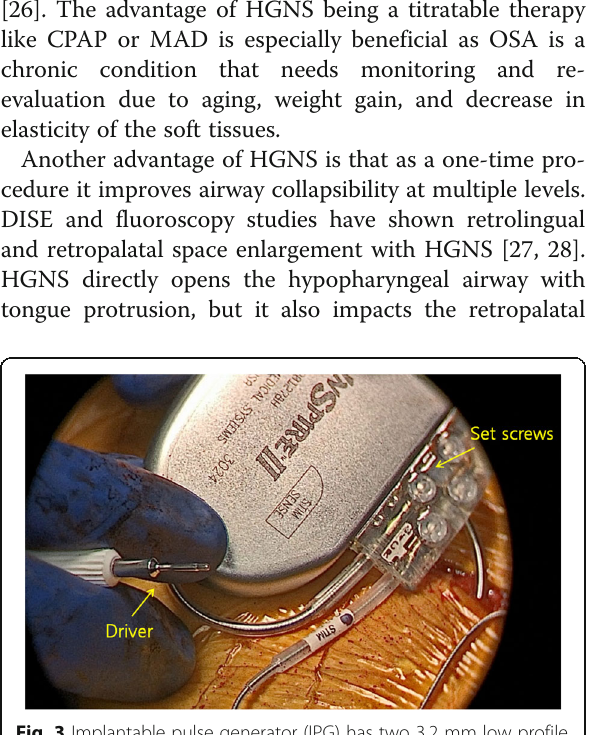
Fig. 3 Implantable pulse generator (IPG) has two 3.2 mm low profile connector ports (STIM port, SENSE port) which house the stimulation and pleural pressure sensing lead connectors. The lead connectors are secured with set screws using a